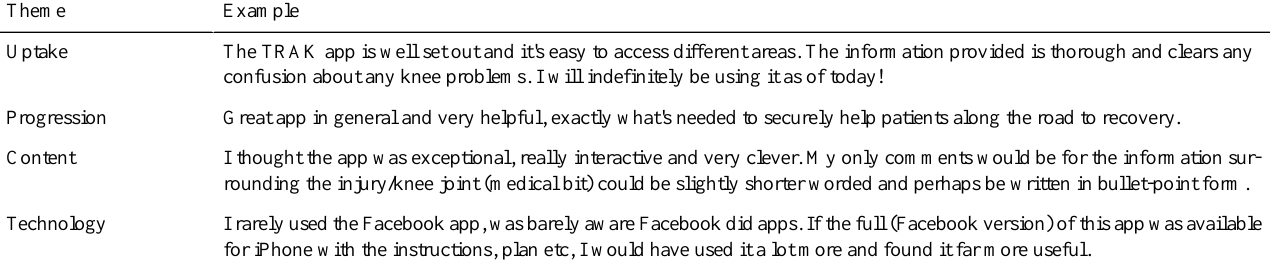
Table 3. A sample of patients'